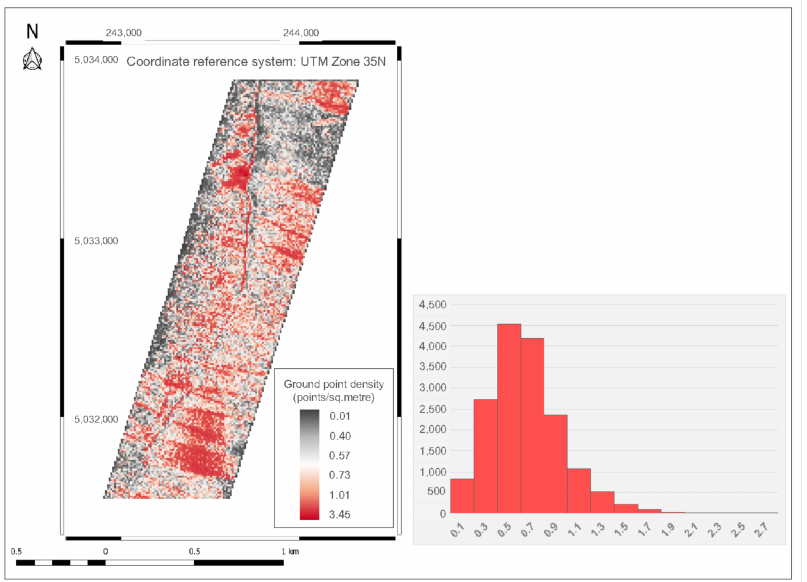
Figure 3. Spatial and frequency distribution of the filtered ground point cloud. The point density grid was generated at a 10 m resolution, to reduce the amount of